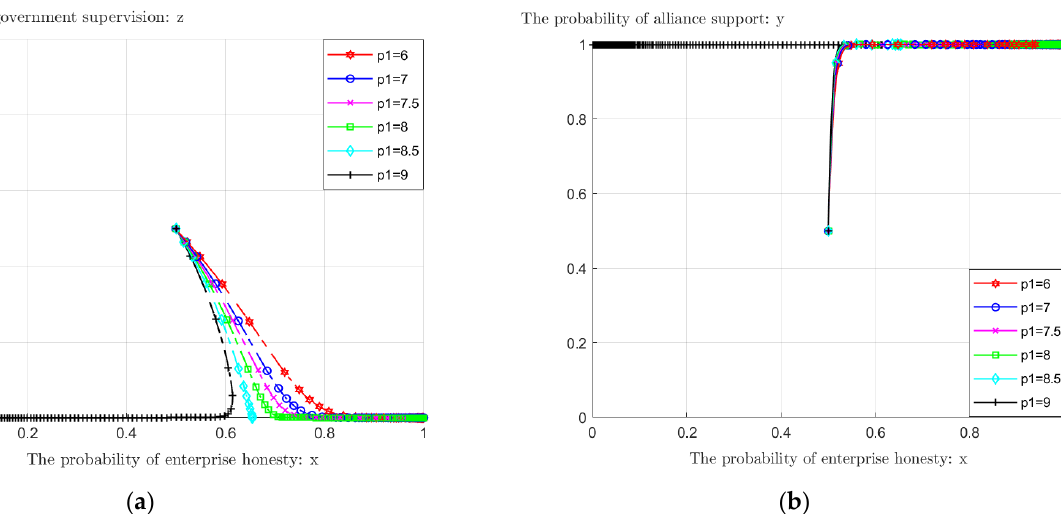
Figure 5. The impact of P 1 change in carbon trading price within the alliance on evolution results: ( a ) impact on the choice of enterprises and government; ( b ) impact on the choice of enterprises and enterprise alliance.